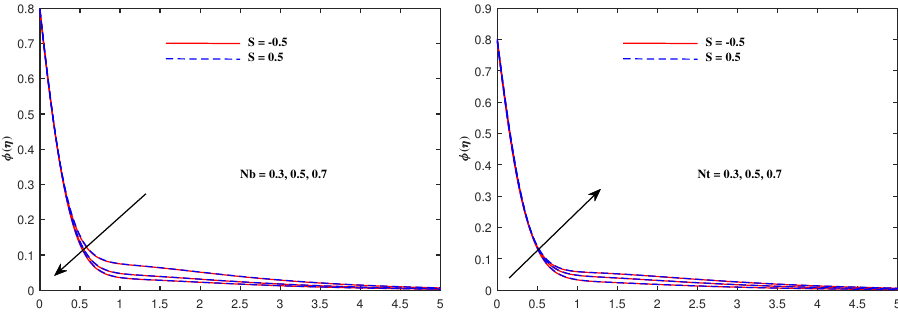
Figure 9. Concentration variation with Nb and Nt .